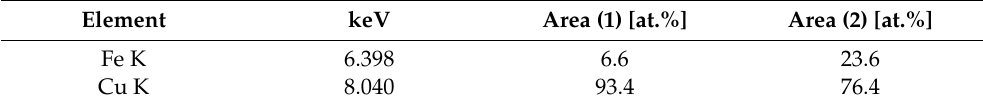
Table 4. The atomic concentration of elements in the Cu+Fe mixture after 90 min of milling from regions shown in Figure 6c.